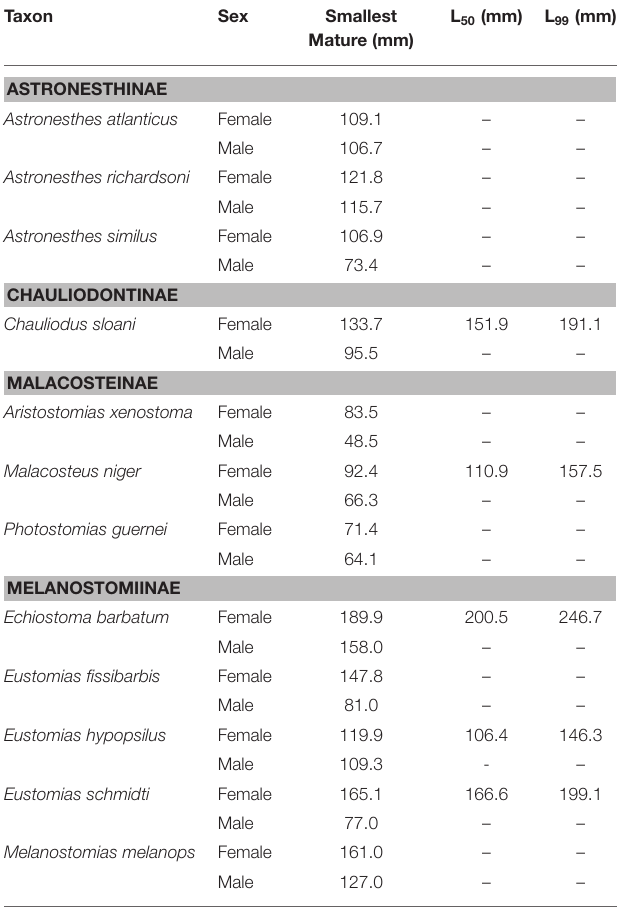
TABLE 4 | Smallest size (standard length) at maturity, length at 50% maturity (L 50 ), and length at 99% maturity (L 99 ) of 12 dominant stomiids in the Gulf of Mexico, listed by subfamily, and